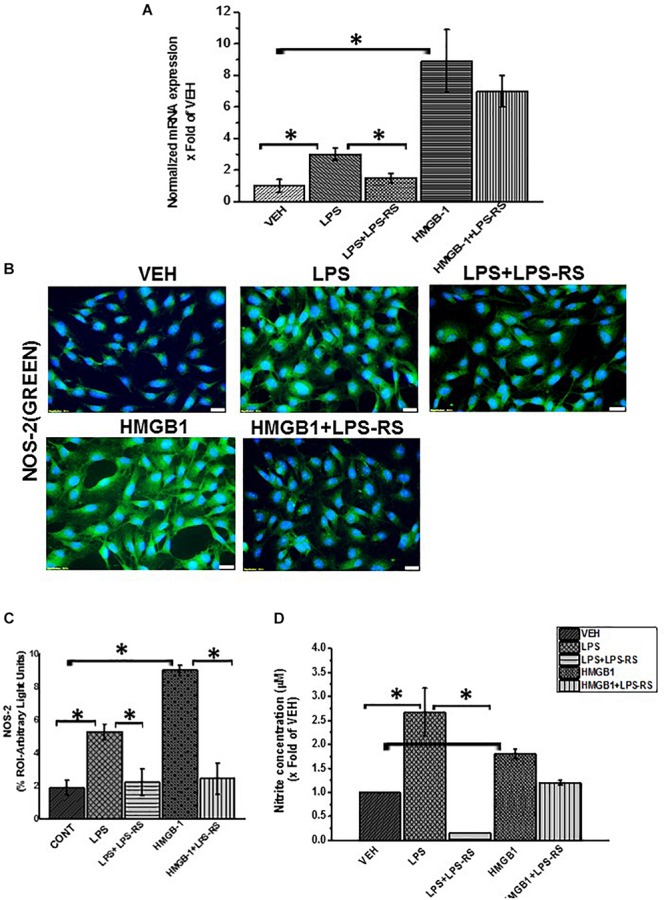
Activation of inducible nitric oxide synthase by LPS or HMGB-1. (A) mRNA expression of NOS-2 in EGC exposed to vehicle control (VEH), LPS, LPS + LPS-RS or HMGB-1 and HMGB-1 + LPS-RS (n = 6) expressed as x fold of the vehicle control. mRNA expression was determined by qRTPCR. (B) NOS-2 protein expression in the cells was detected by staining with green fluorescent antibody and counterstained with DAPI (blue) and viewed at (total magnification 400 μm and scale 20 μm). (C) Quantitative morphometric analysis of NOS-2 in rat EGC per 100 cells in different fields and represented as immunoreactivity in the region of interest (% ROI). (D) Nitrite concentration in EGC (n = 8). Nitric oxide production in EGC supernatants was estimated by Griess assay from freshly harvested supernatants. Nitrite concentration is reported as X fold increase over the vehicle control (VEH) (∗P < 0.05).